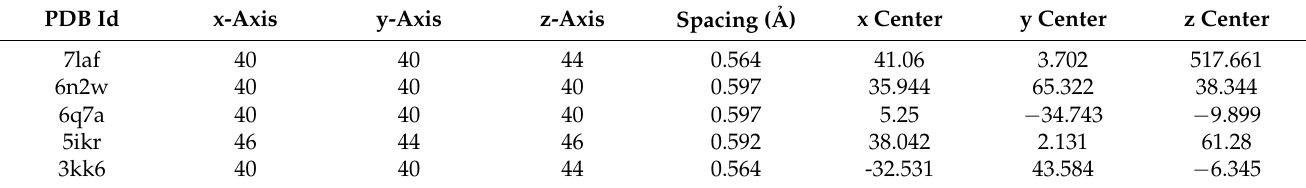
Table 5. Coordinates used to prepare grid-box for various macromolecular targets involved in the current computational